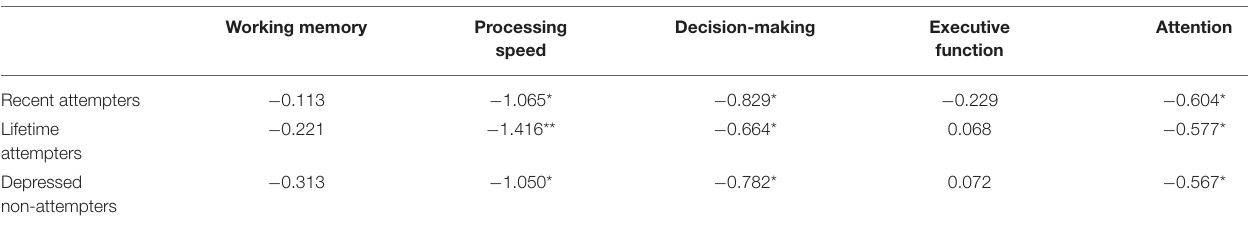
TABLE 4 | Multiple regression a